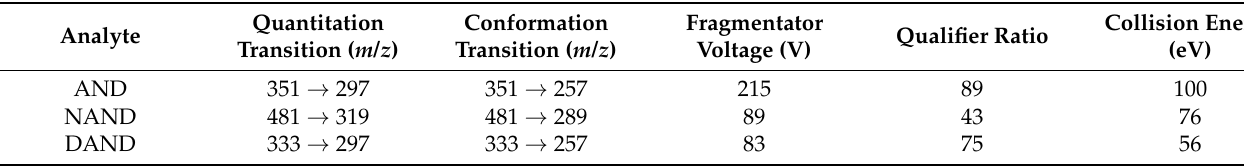
Table 5. MS parameters for andrographolides.